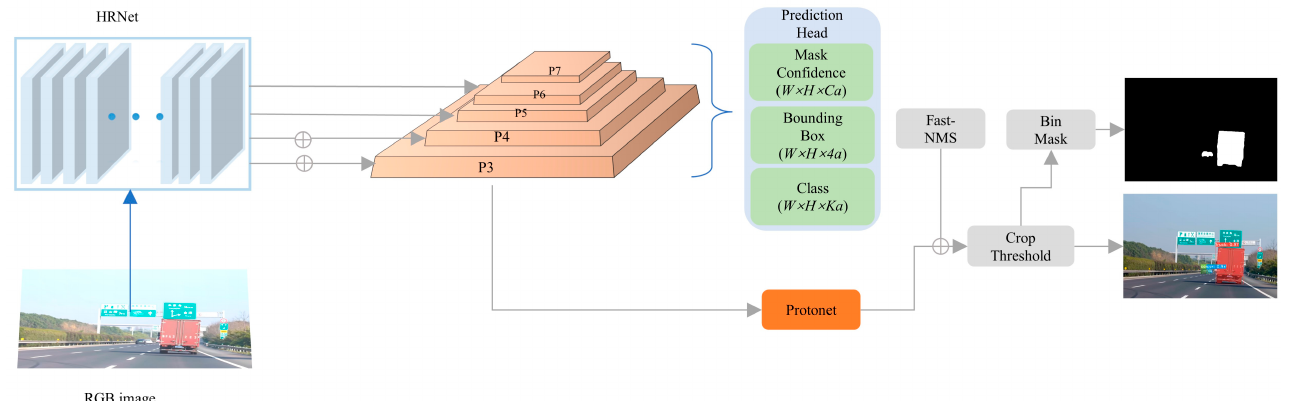
Figure 3. YOLACT-Road improves instance segmentation. HRNet is the high-resolution network, HRFPN is the feature pyramid of the backbone network channel, and P3–P7 are FPN-based feature map layers. The network’s prediction head is the mask coefficient prediction head, the bounding box prediction head, the category prediction head, W, H, Ca, 4a, and Ka. The prototype network runs parallel to the prediction head. The GPU matrix operations-based binarization mask module generates masks. Mask Filters preprocesses masks.